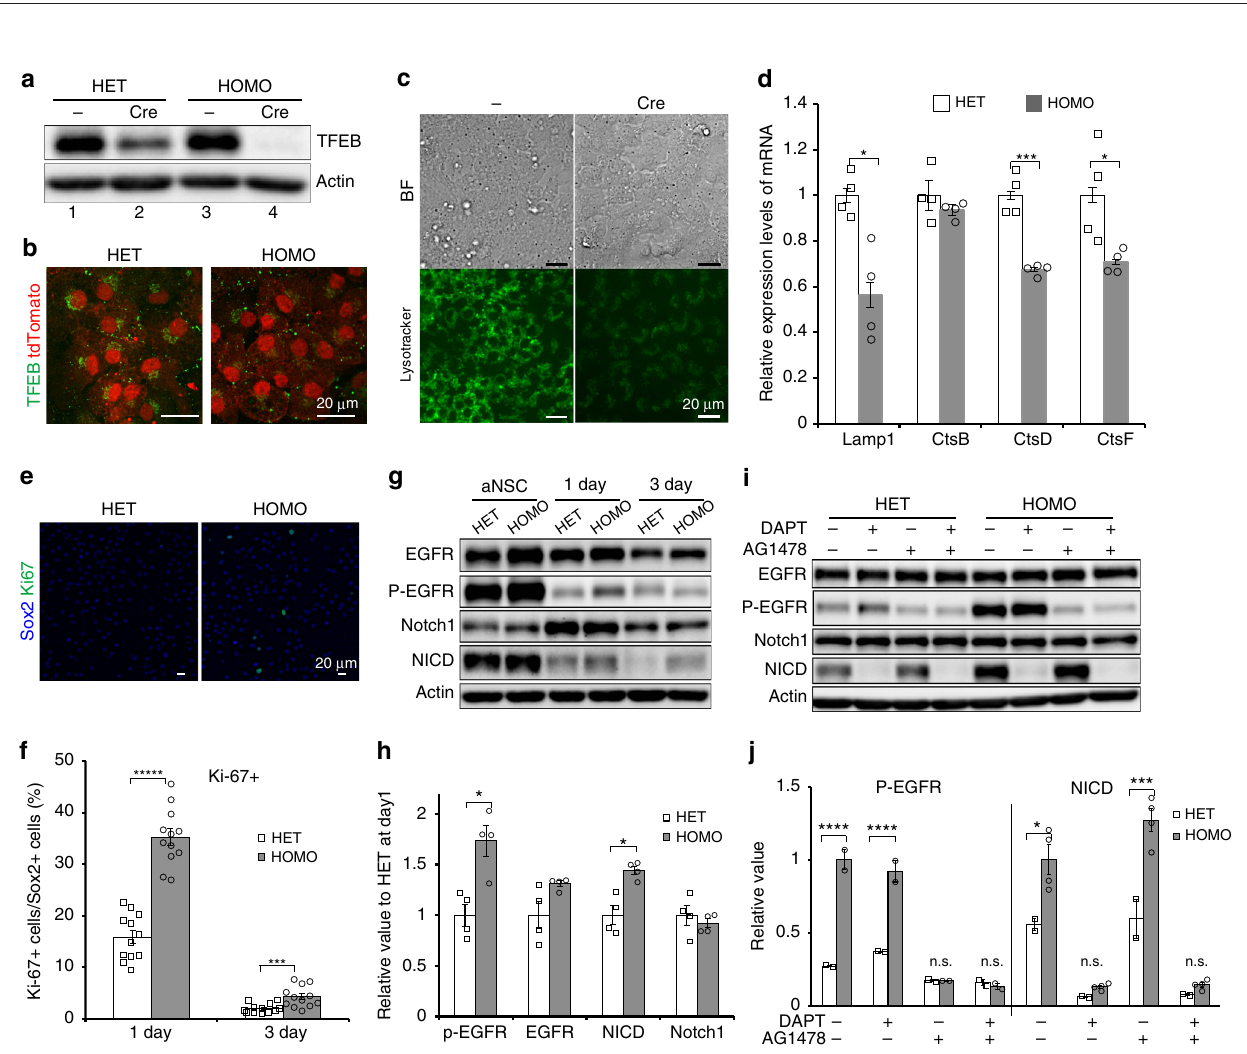
Fig. 5 Effects of activated lysosomes on aNSC proliferation. a Pharmacological activation of lysosomes in aNSCs. Representative immunoblots for TFEB, cyclin D1, and actin after incubation with DMSO (Ctrl), 1 nM Torin-1 (Torin), or 10 µ M rapamycin (Rap) for 0, 4, 8, or 12 h. b Quanti fi cation of cyclin D1 shown in a . c Immunocytochemistory of TFEB-GFP (green) in the wild type or cells expressing two constitutive-active mutants (mt1: S141A; mt2: S210A) with DAPI (blue) under the control of the tet-on inducible system on 1 day. White arrowheads indicate nuclear localization of TFEB-GFP. d Representative immunoblots for GFP, TFEB, and actin in the presence or absence of doxycycline (dox). e Proportions of Ki-67 – positive cells in TFEB-GFP – expressing cells on 1 day and 3 day. Values are shown relative to wild-type TFEB-GFP. Scale bars, 10 µ m. Data represent means ± s.e.m. (* P < 0.05 and ** P < 0.01; Student ’ s t- test for b and e ). f Schematic diagram of the delivery of lentiviral vectors encoding TFEB-GFP driven by the Hes5 or GFAP promoter into the DG. g Representative images from 50- µ m-thick FF-IHC sections. Mice were fi xed 3 days after virus injection. For counting, every sixth slice through the whole DG was immunostained with GFAP, GFP, Ki-67, and Sox2 antibodies. h Percentages of Ki-67 + aNSCs among total GFP + NSCs (box plot: center line, median; box limits, upper and lower quartiles; whiskers, minimum and maximum). Corresponding data points were plotted as open diamonds. Cells were counted in the SGZ of around six slices for each condition per mouse, using the Imaris software. Data represent means ± s.e.m. (* P < 0.05; Tukey ’ s test. n = 5). Source data of immunoblots are provided as a Source Data fi le.